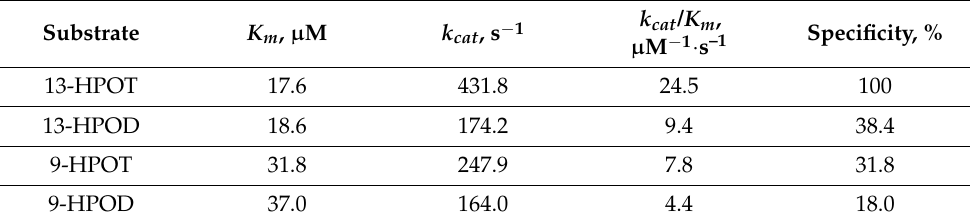
Table 1. Kinetic parameters of the recombinant CYP440A18 enzyme towards C 18 fatty acid